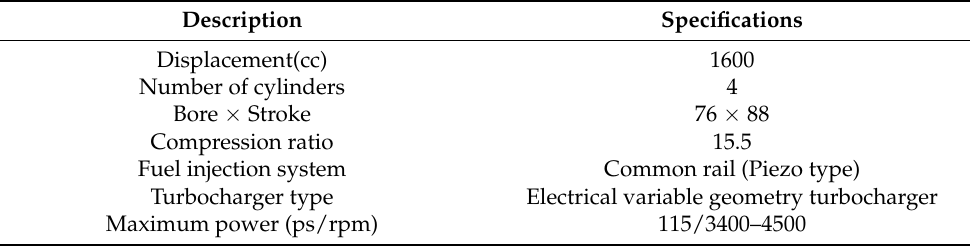
Table 4. Specifications of the engine.